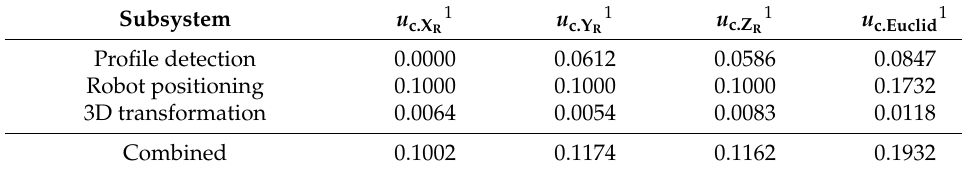
Table 4. Contributions of each subsystem to the combined standard uncertainty for separate direc- tions and Euclidean distance.